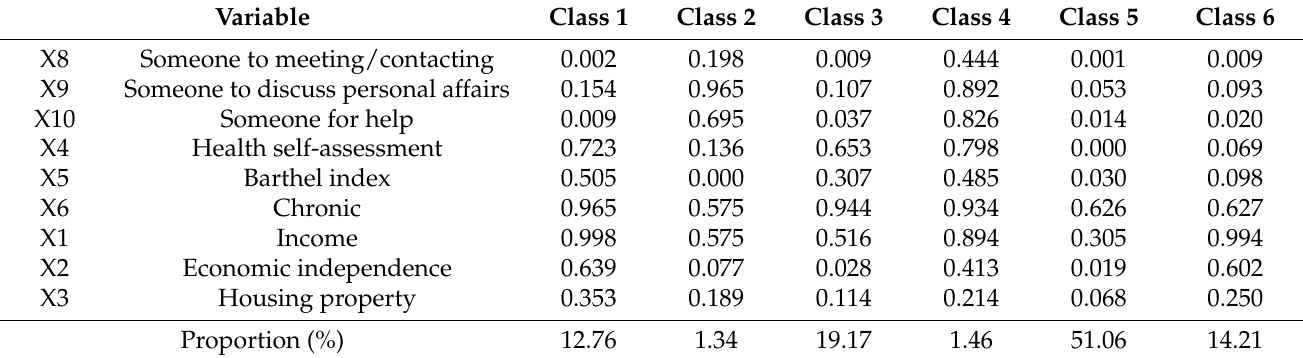
Table 6. Latent class coefficients for six-class model of vulnerable older